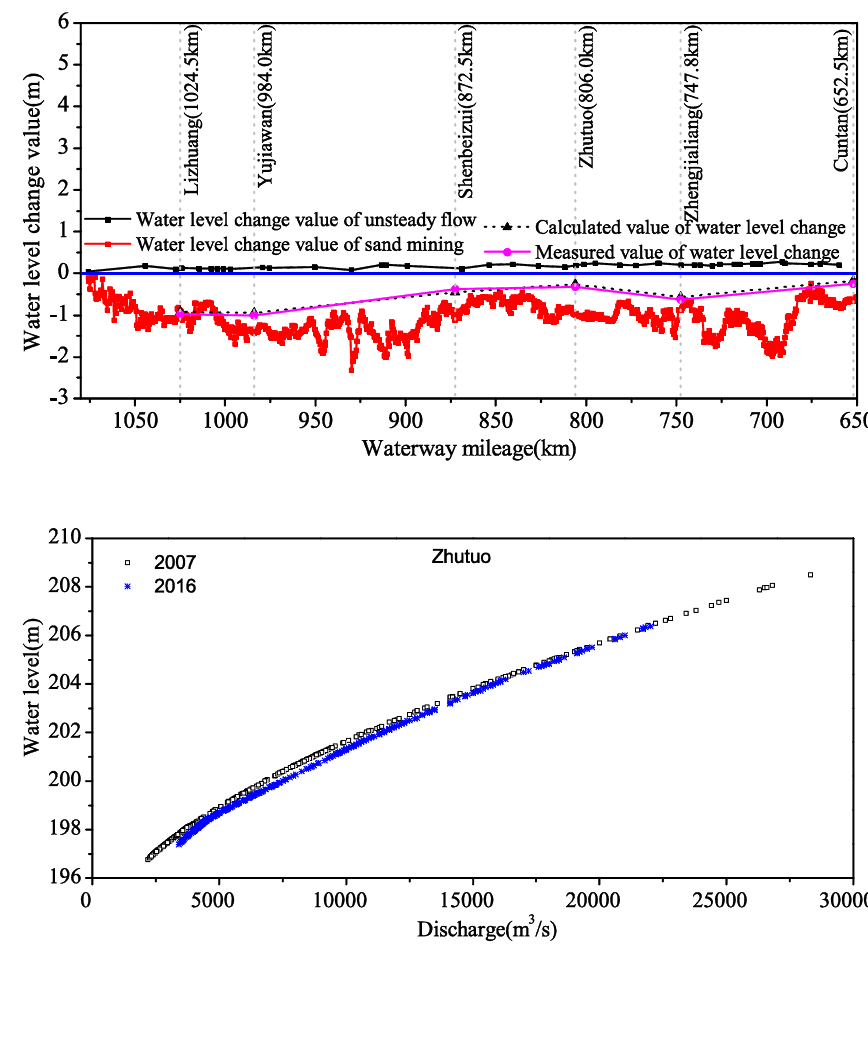
Table 6 Water level results at the main sites